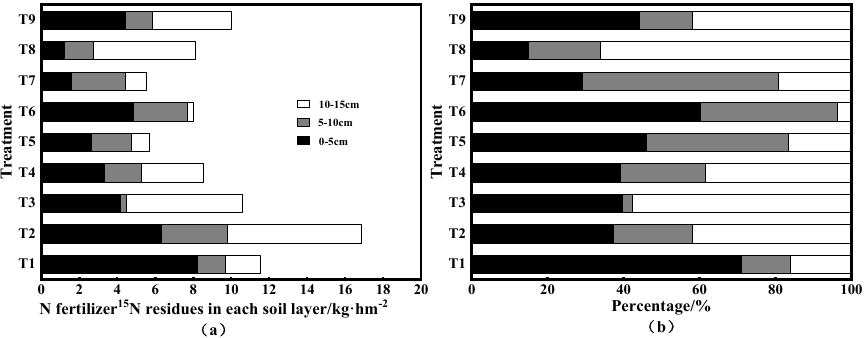
Figure 3. The residual amount of 15 N fertilizer in each soil layer after the mung bean harvest and the residual amount of 15 N fertilizer in each soil layer as a percentage of the total residual nitrogen fertilizer.